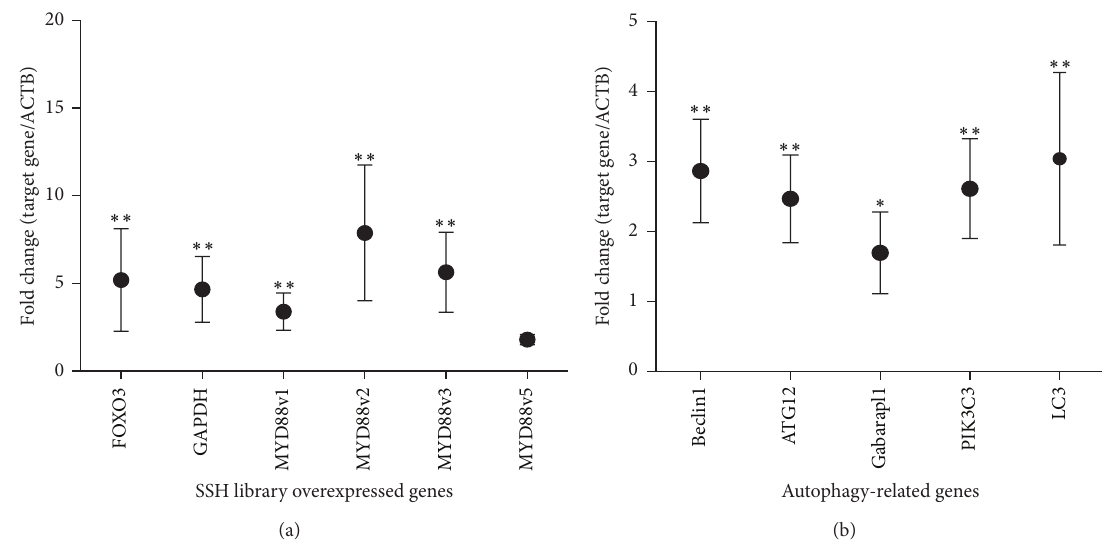
Figure 3: Relative expression of genes identified from the SSH library, MYD88 isoforms- and autophagy-related genes in esophageal cancer tissues, assessed using real-time PCR. (a) Relative expression levels of genes that are overexpressed in esophageal tumor (FOXO3, GAPDH, and MYD88 variants). Expression of MYD88v4 was not detectable in samples. (b) Detection of autophagy in esophageal tumors. Relative expression of autophagy-related genes (Beclin1, ATG12, Gabarapl1, LC3, and PIK3C3) in esophageal tumor tissues. ( e ) represent the mean and whiskers the SEM of expression in samples ( 𝑛 = 10 ). ∗ 𝑃 < 0.05 , ∗∗ 𝑃 < 0.01 .